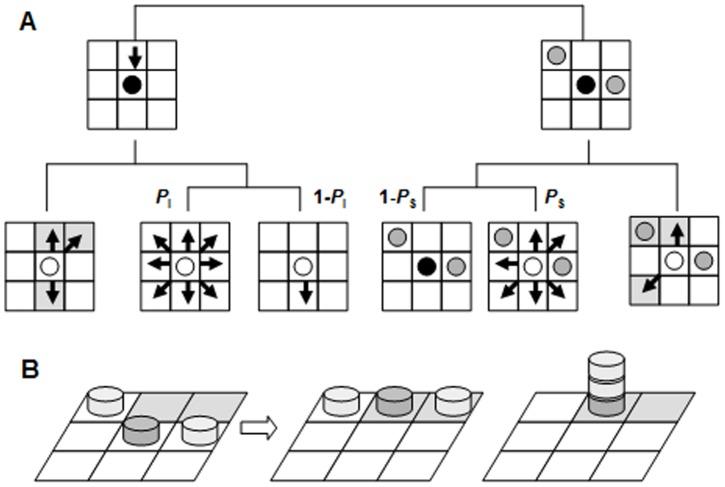
Schematic diagram of the foraging ant model.(a). Movement rules of the foraging ant model. An ant at the center of a neighborhood (black circle) chooses its next location depending upon the conditions of its neighborhood. The first condition is the presence or absence of other ants, depicted as gray circles (top row). The black arrow represents the ant's direction of movement. The second condition is the presence or absence of a food source, depicted as gray cells. Finally, the probabilities of different possible movements are determined by P
I and P
S. The possible movements are represented by black arrows (bottom row). (b) Difference between asynchronous (center) and synchronous (right) updating in the next state resulting from a given previous state (left). Gray coins represent foraging ants.